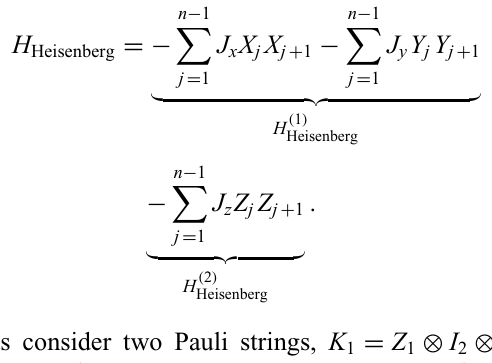
(cid:8) (cid:9) 1 conjugated by Pauli X operators (see Fig. 2